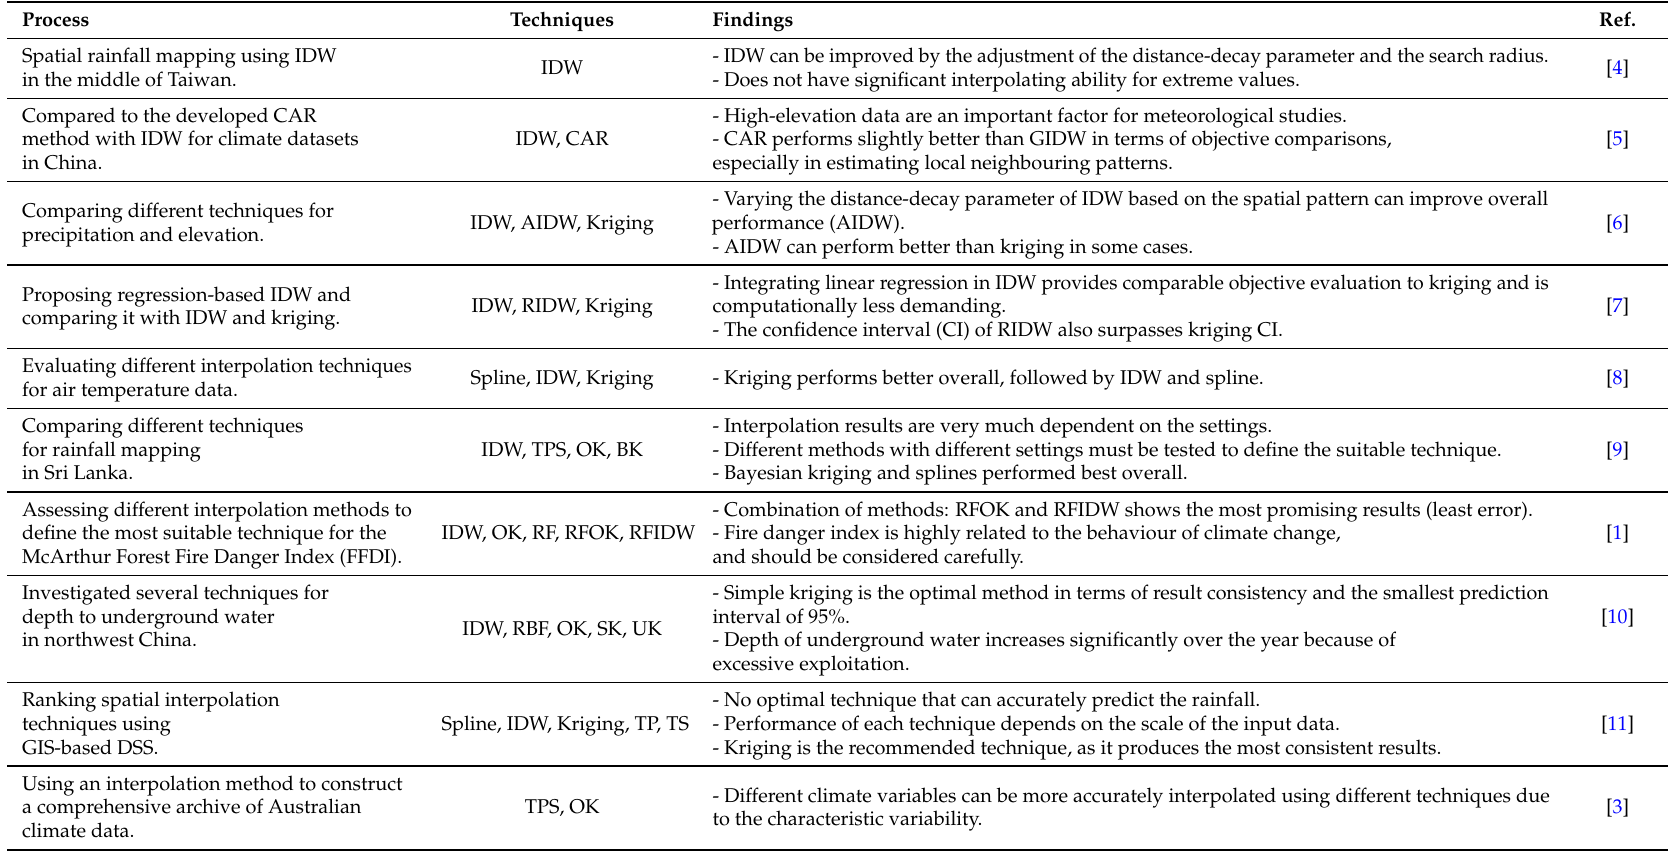
Table 1. List of previous studies that utilised different interpolation techniques for environmental studies, and the findings from each study are also provided. Comparing methods as done here cannot be generalized, as this is limited to the empirical exercises, and no rigorous theoretical demonstration is provided (the table is sorted based on the similarity of interpolation techniques adopted and compared in each